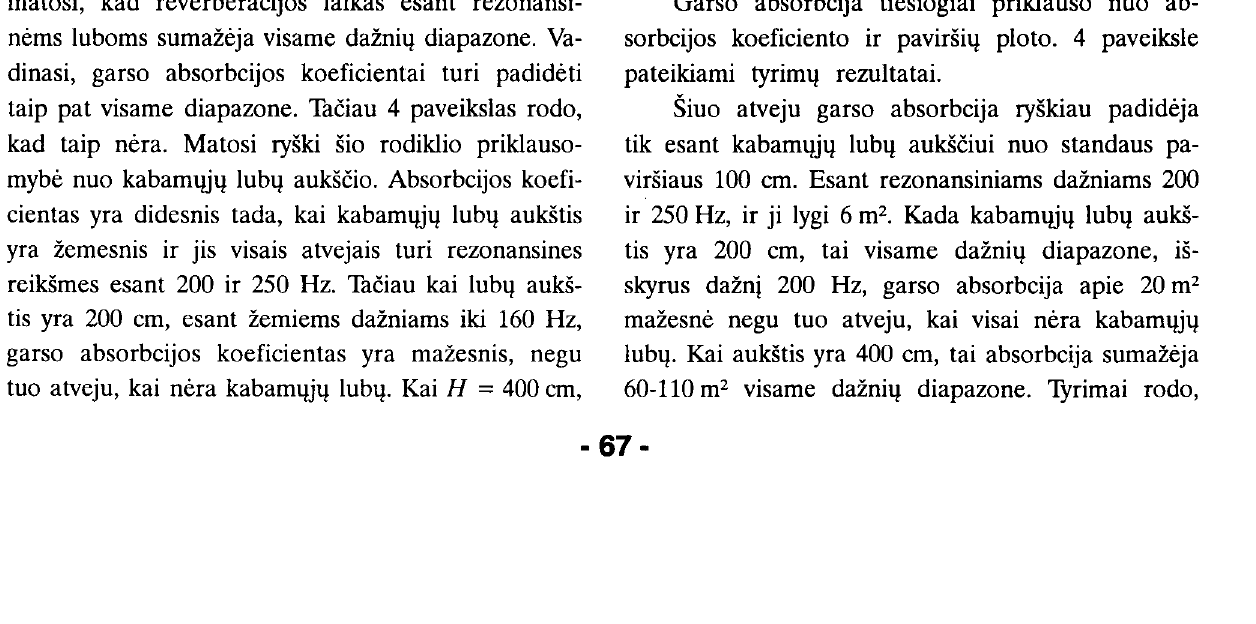
5 pav. Santykine garso absorbcijos ki timo priklausomybe nuo kabamqjq lu bq atstumo iki standaus lubq pavir siaus. Kryziaus formos plysio plotis 50 em. Matavimo ta8kas 1. 1 - H = 0; 2 - H = 100 em; 3 - H = 200 em; 4 - H = 400 em Fig. 5. Dependence of the change in the relative sound absorption upon the distance of the suspended ceiling from the hard surface of the ceiling. The area of the cross-shaped aperture is 50 em. Measurement point